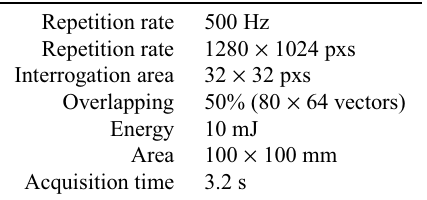
Table 1: Diode pumped Nd:YLF